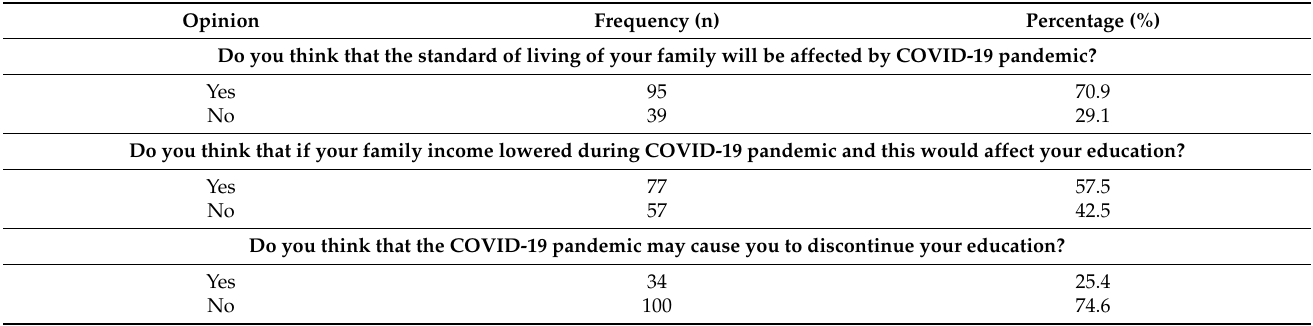
Table 8. Impact of COVD-19 on economic status and educational